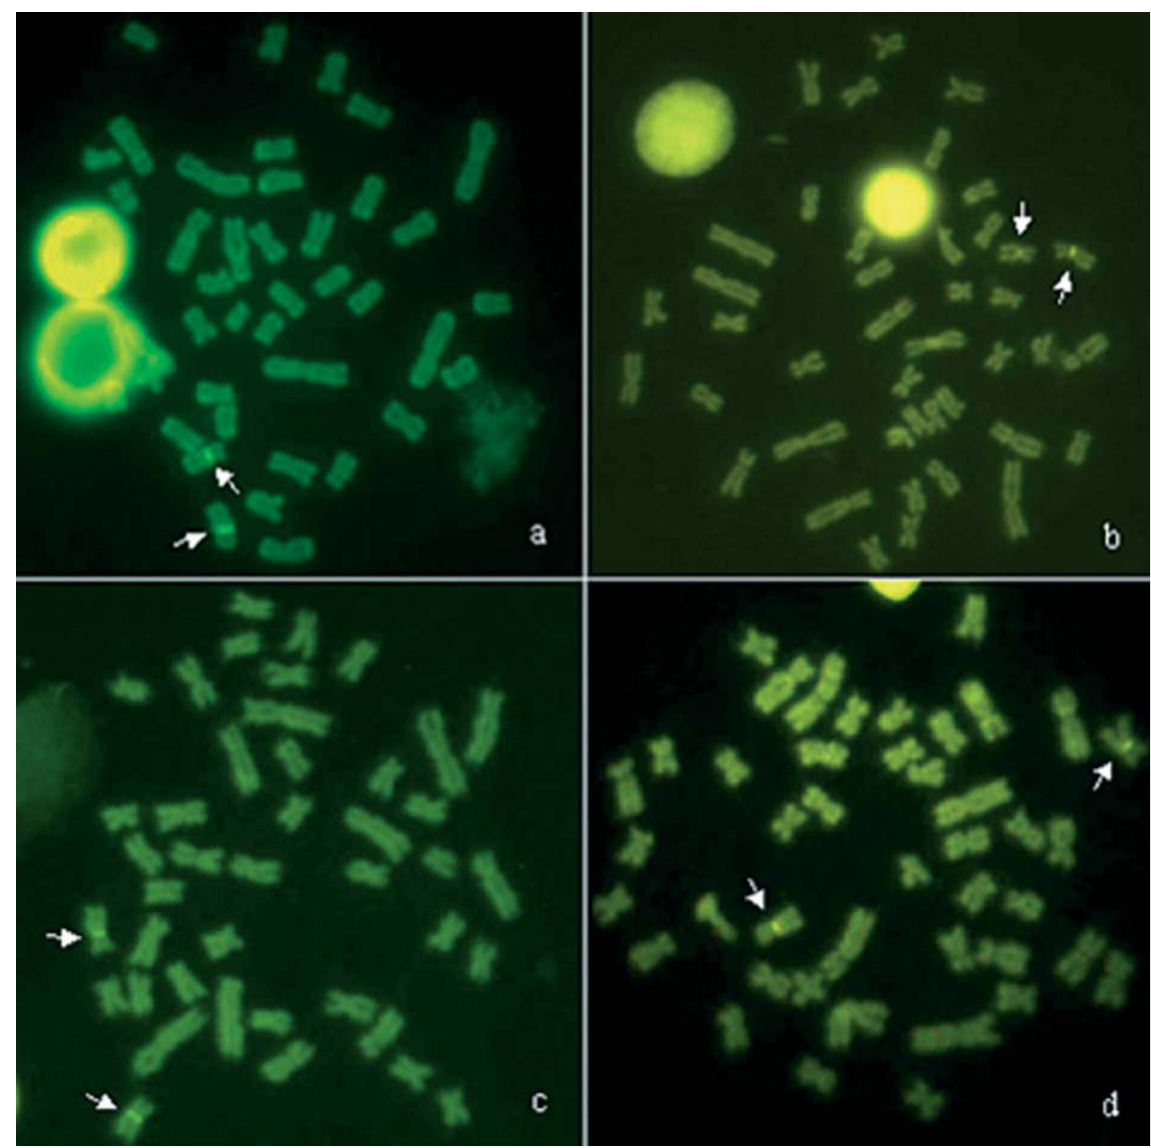
Figure4 -Metaphasesof Hopliasmalabaricus fromtheRibeira(a),Tibagi(b),Ivaí(c),andIguaçu(d)populationsstainedwithchromomycinA 3 .Thear - rows indicate the bright fluorescent bands that correspond to GC-DNA-rich segments located on chromosome pair n.